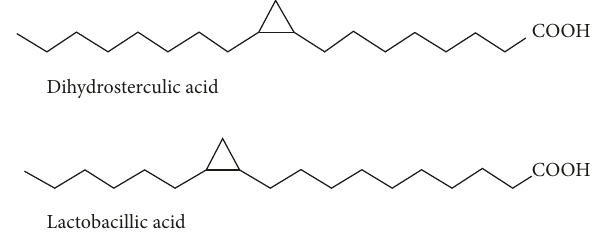
Figure 1: Main cyclopropane fatty acids detected in dairy